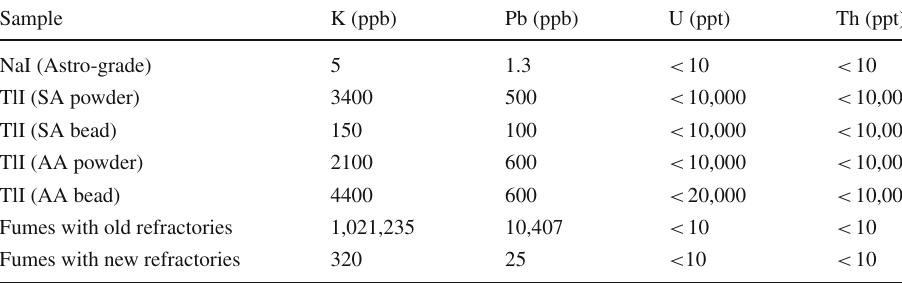
Table 1 ICP-MS results for: initial materials; fumes produced during the growing